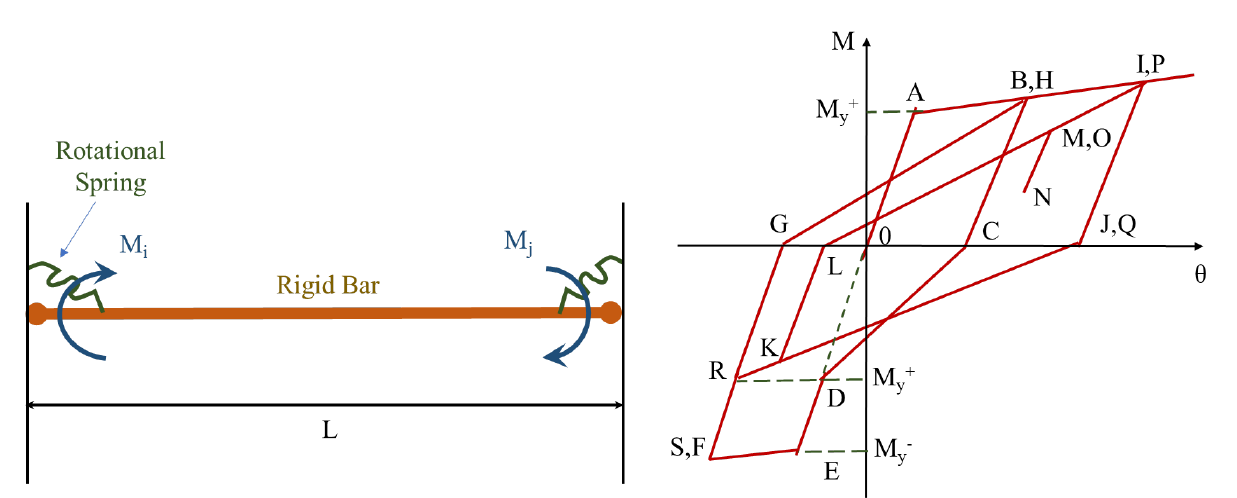
Figure 2. Fixed-end rotations and corresponding deterioration in joint hysteretic behavior, reproduced from literature [19].